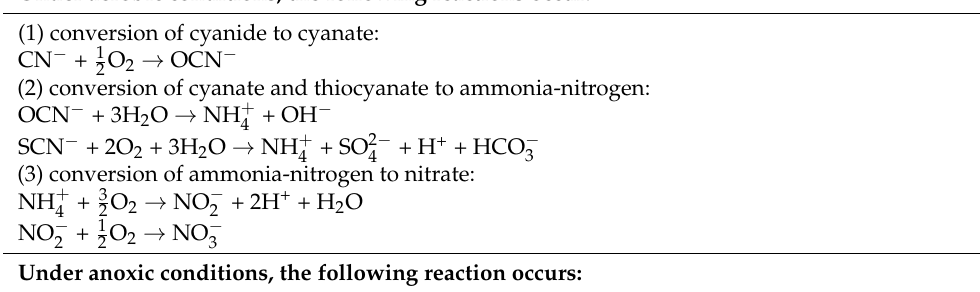
Table 1. Biological removal of nitrogen compounds.